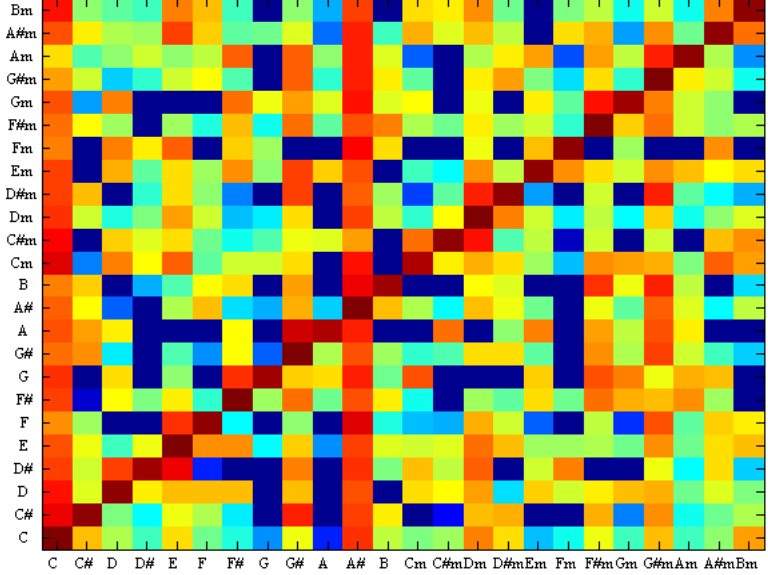
Figure 10. Confusion between chords with SVM. Appl. Sci. 2016 , 6 , 157